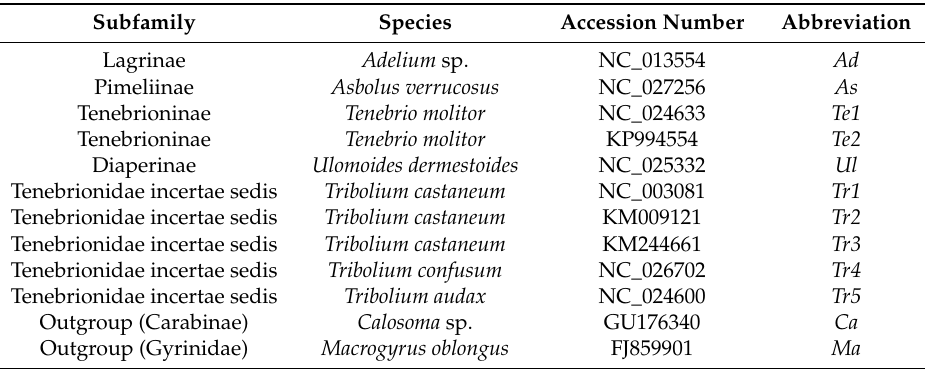
Table 1. List of taxa used in this